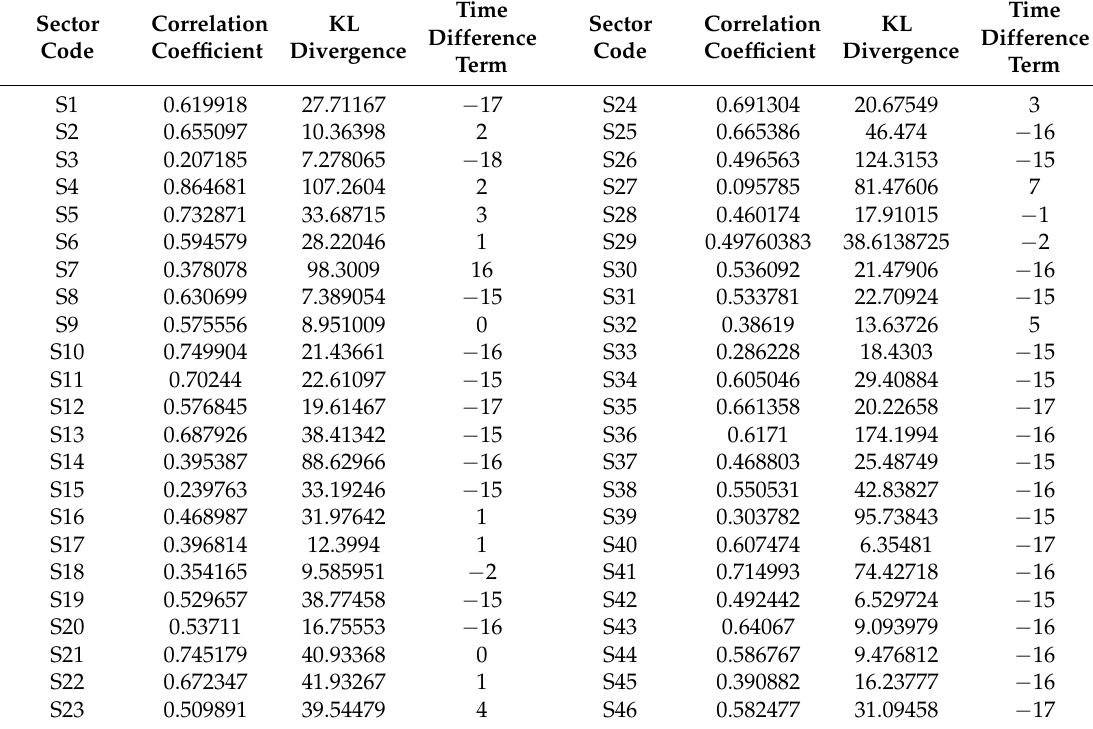
Table 3. The results of time difference relationship for 46